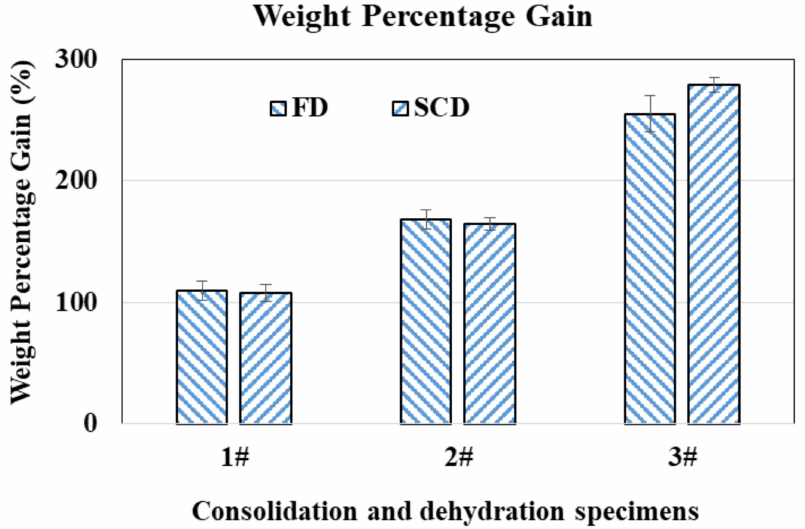
Figure 2. Weight percentage gain of specimens from different samples.